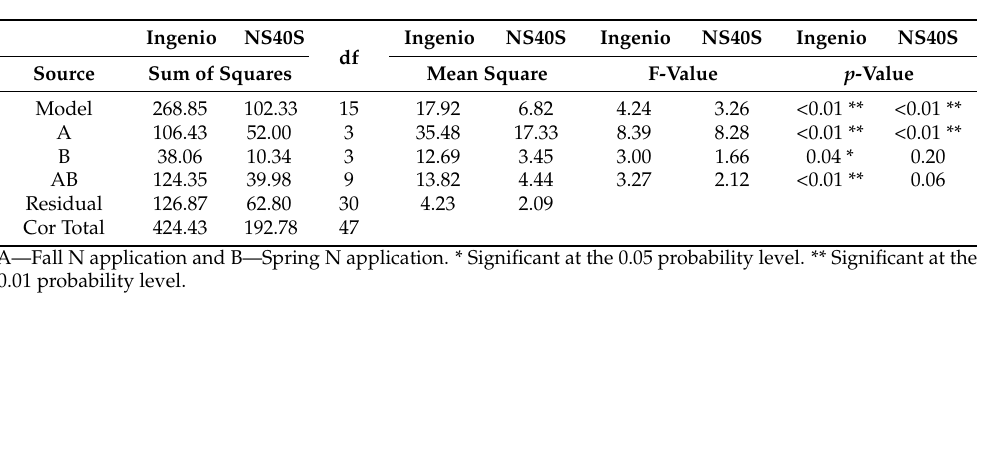
Table 10. ANOVA table for biomass of NS40S in